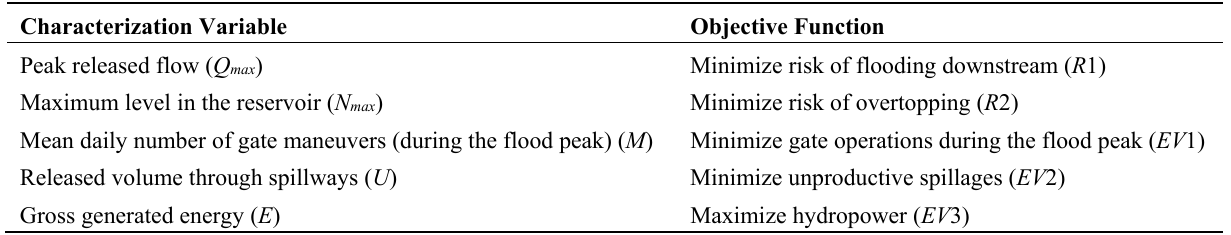
Table 1. Variables considered that characterize aspects of the hydropower flood control operations. Characterization Variable Objective